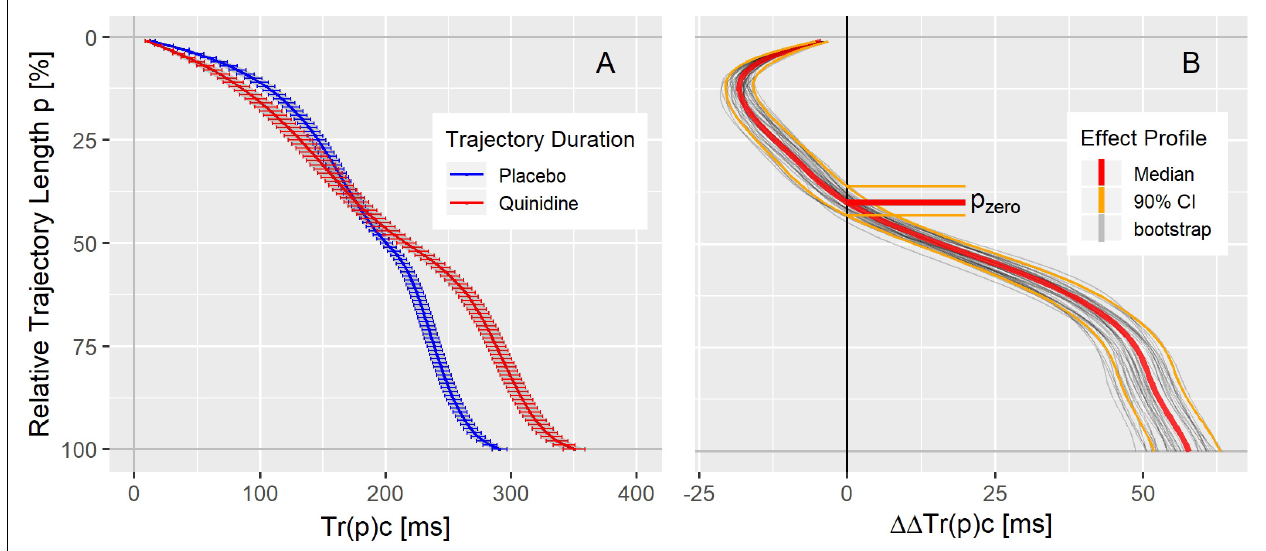
FIGURE 4 | (A) Average population T vector trajectory duration curves corrected for heart rate Tr(p)c in study A under placebo (blue) and quinidine (red) calculated for the plasma concentration of 1754 ng/mL with two-sided 90% confidence intervals. (B) Quinidine effect profile, showing the placebo corrected change from baseline Tr(p)c. The red lines denote the median, and the orange lines the 90% coverage of the bootstrap simulated continuous effect profiles. Gray lines are a subset of individual bootstrap simulations. The distribution of the zero-transition percentage p zero of the simulated effect profiles (median: 5 and 95% quantile) is indicated by the horizontal lines.